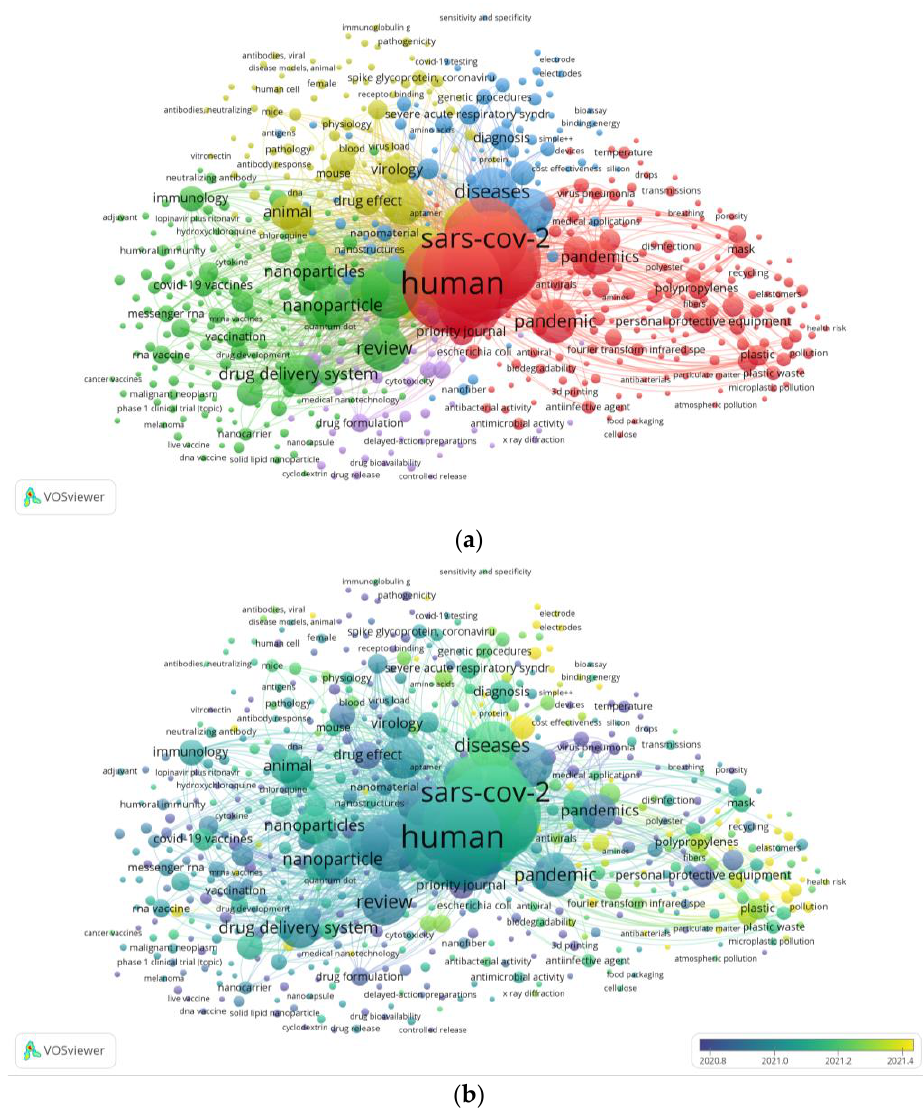
Figure 4. ( a ) Network visualization of all keywords (weights: occurrences). ( b ) Overlay visualization of all keywords in 2019 – 2022 (weights: occurrences; score: average publications per year).